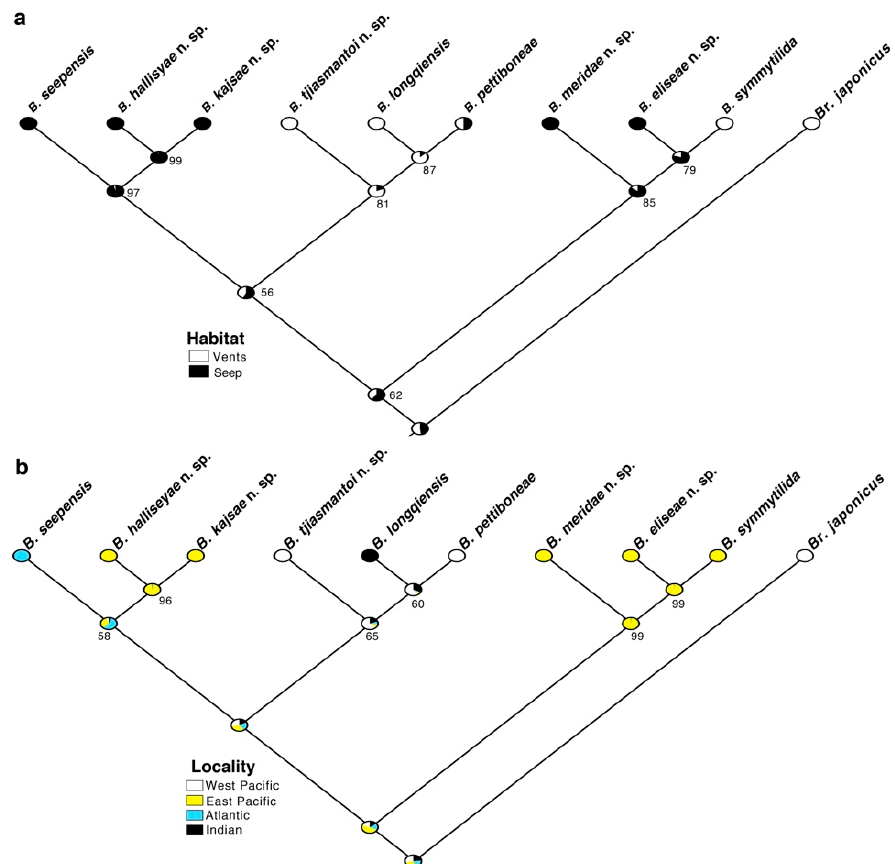
Figure 6. Maximum likelihood tree topology from concatenated data (COI, 16S, and ITS) with the transformation for ( a ) habitat: vent or seep and ( b ) geographic locality, under the MK1 model. ‘Pie charts’ at the nodes represent probabilities for the relevant states. Where one state was above 50% likelihood, the number is written at the node.